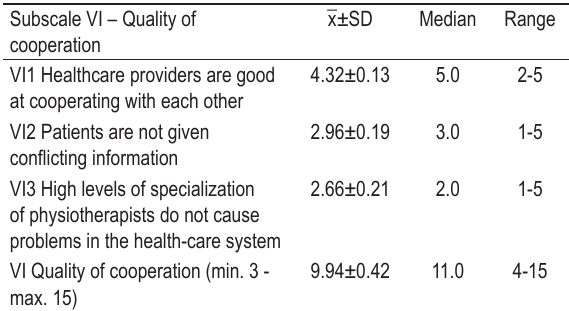
TABLE 7. Overview of mean scores – subscale VI – Quality